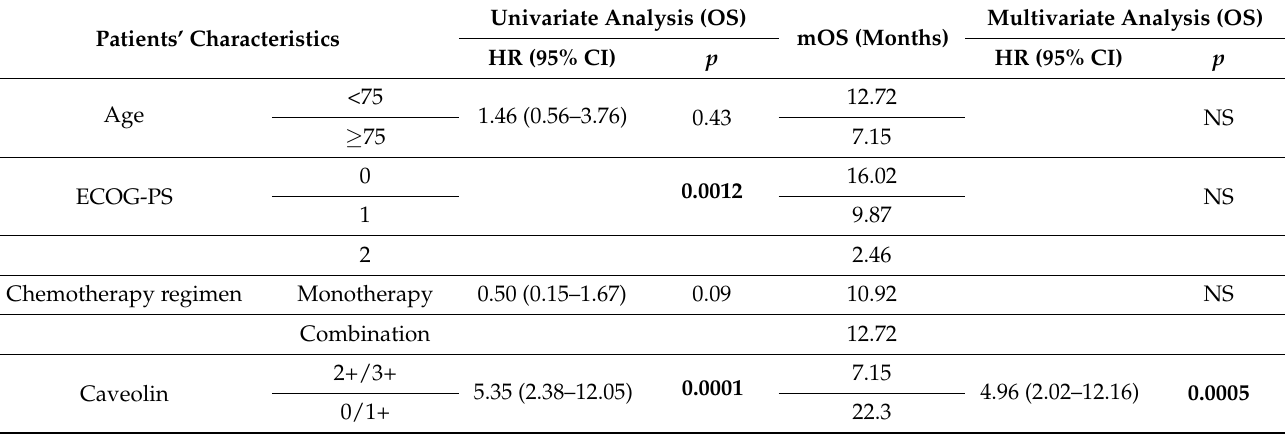
Figure 3. OS by positive (0 and 1+ vs. 2+ and 3+) Caveolin-1 expression in the whole cohort. Median OS: 7.15 vs. 22.30 months (HR: 5.35, 95%CI: 2.38–12.05, p = 0.0001). Table 4. Univariate analysis and multivariate analysis for Overall Survival.